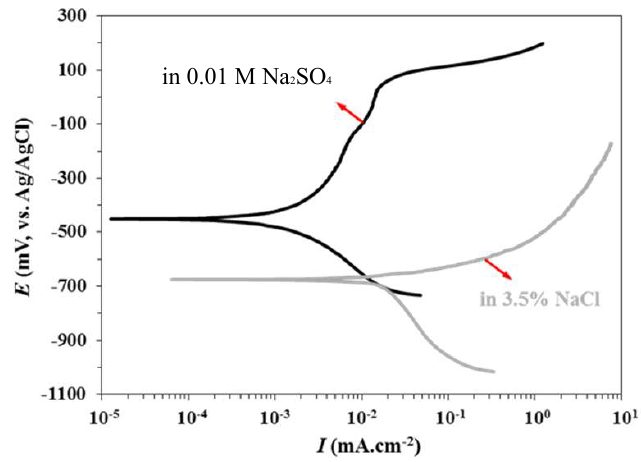
Figure 9. Potentiometric polarization curves of the Cu–10Sn cold-sprayed coatings in 3.5 wt % NaCl (alkaline) and 0.01 M Na 2 SO 4 (acidic) electrolyte solutions at room temperature. Table 2. Some important corrosion parameters calculated from PDS curves.